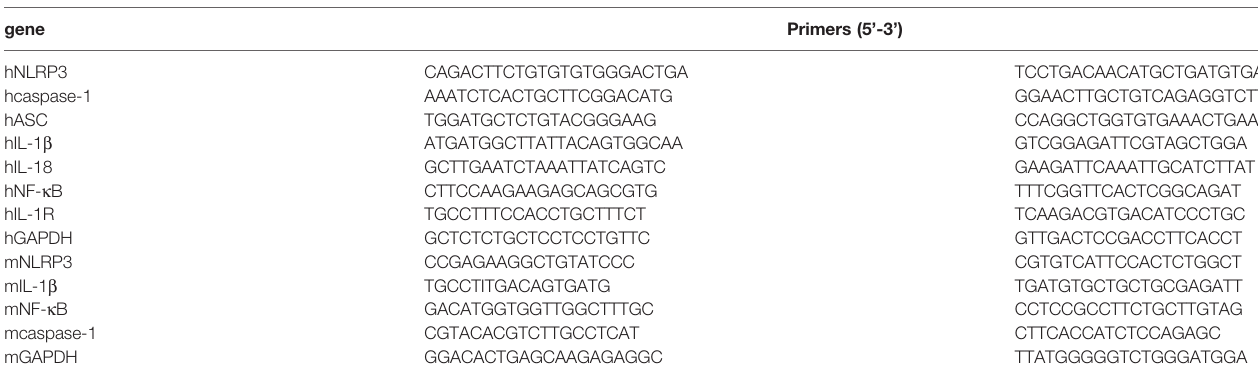
TABLE 2 | The sequences of PCR primers.